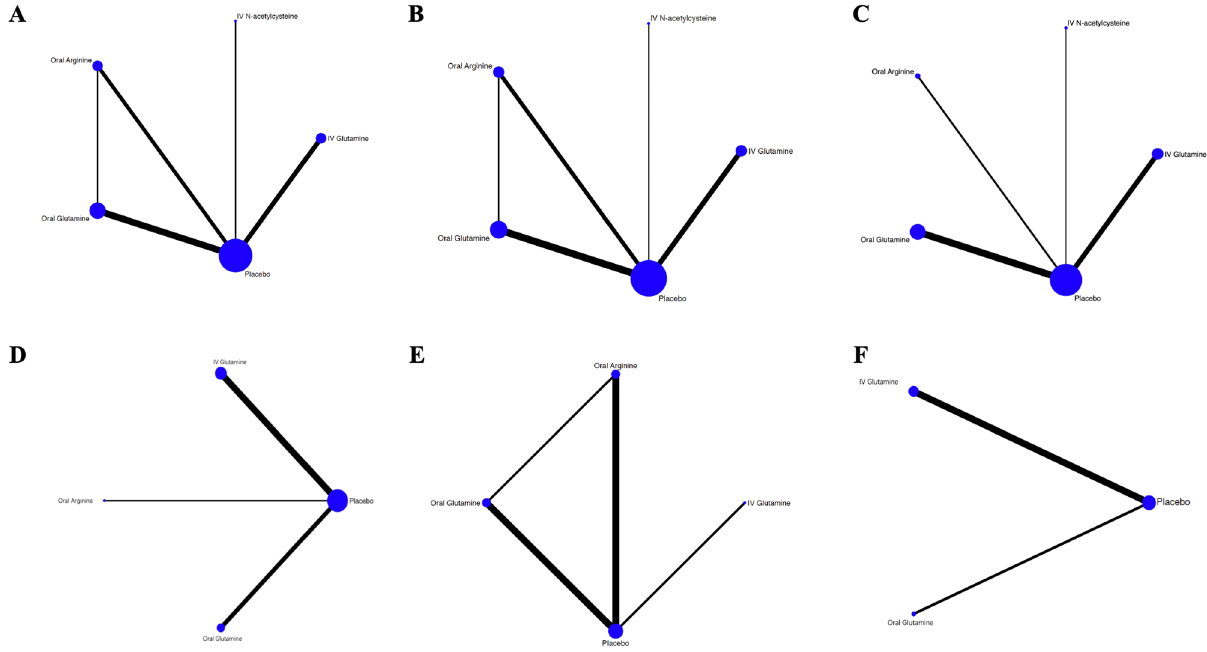
Figure 2. Network meta-analysis plots. ( A ) All-cause mortality, ( B ) severe NEC, ( C ) Late Onset Sepsis, ( D ) Length of hospitalization, ( E ) NEC-related mortality, ( F ) Time to achieve full enteral